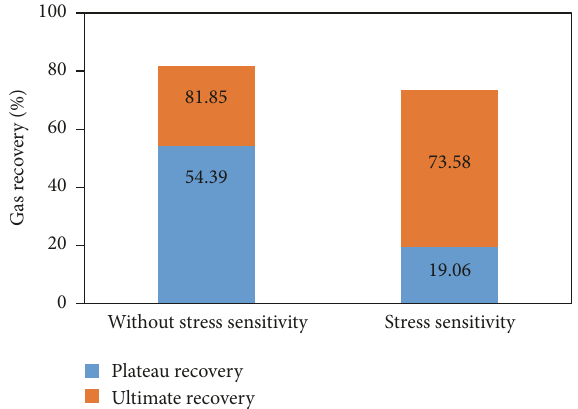
Figure 12: Gas recovery of different periods with or without stress sensitivity.